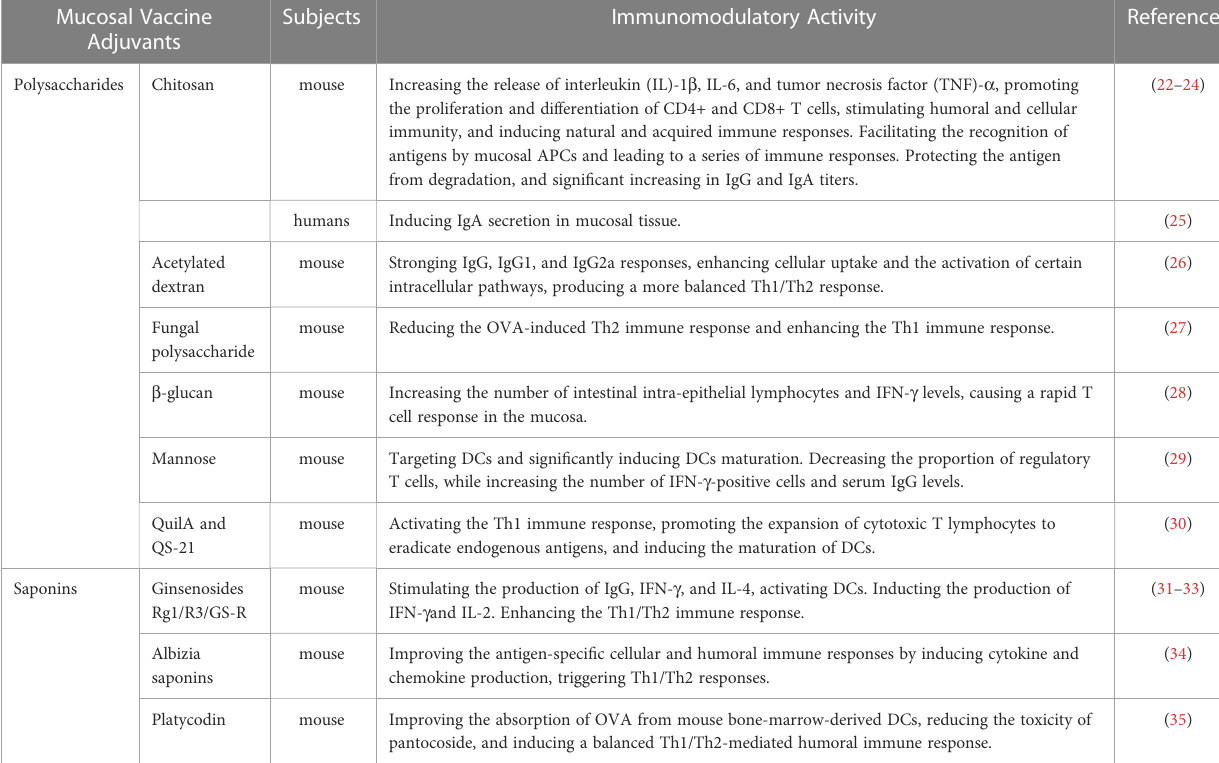
TABLE 1 List of some natural-product-based mucosal vaccine adjuvants and their lmmunomodulatory effect. Mucosal Vaccine Adjuvants